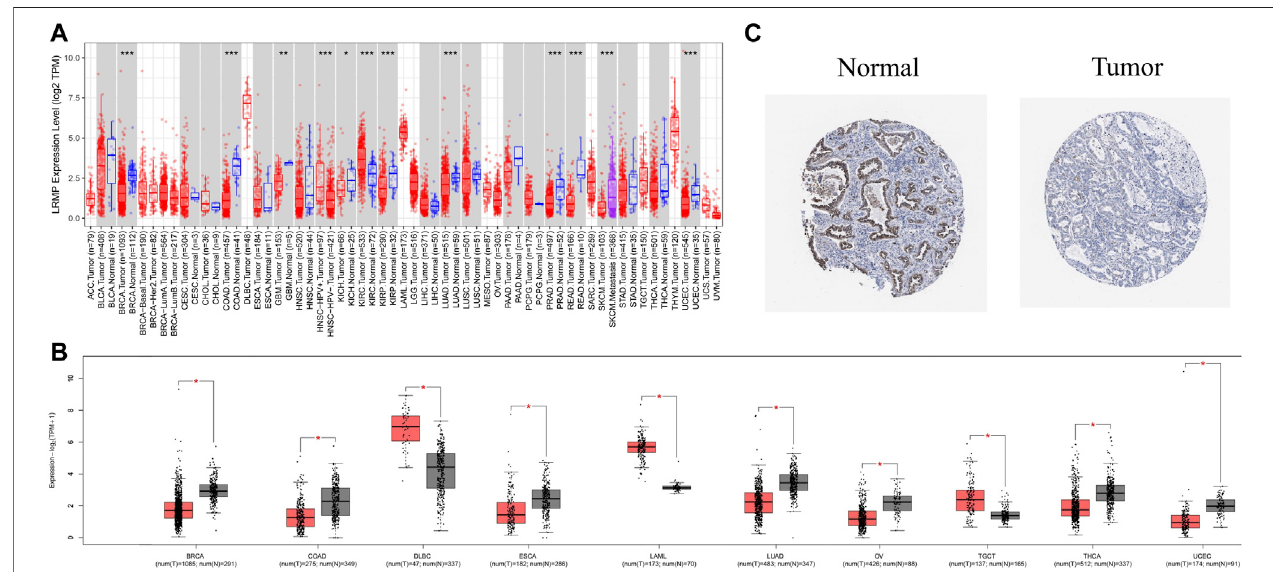
FIGURE 1 | The expression level of lymphoid-restricted membrane protein (LRMP) in different human cancers. (A) Increased or decreased expression of LRMP in cancerscomparedwithadjacentnormaltissueinTumorImmuneEstimationResource(TIMER)database. (B) LRMP expressionlevelindifferentcancerscompared with GTEX data in GEPIA 2. (C) LRMP protein expression in normal tissue and tumor tissue of patients with LUAD.